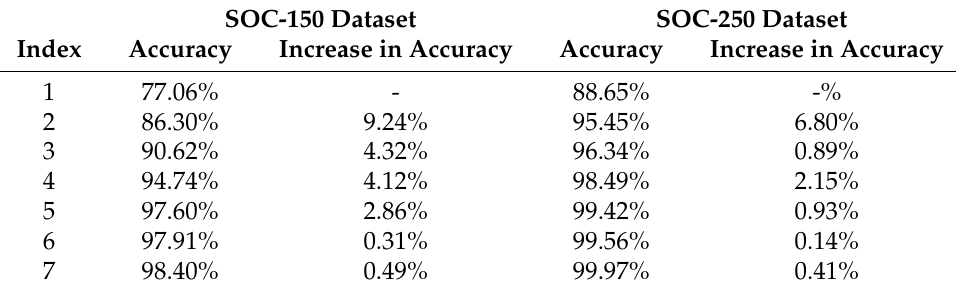
Table 9. Recognition accuracy of ablation